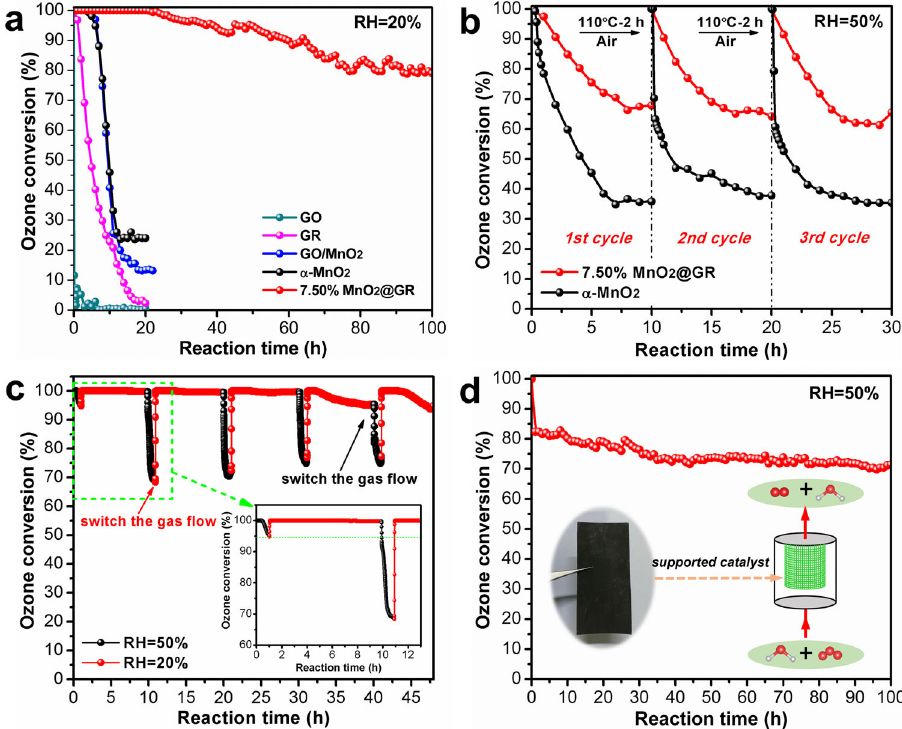
Fig. 4 The highly ef fi cient ozone conversion with the 3D hierarchical MnO 2 @GR. a Ozone conversion on GO, GR, α -MnO 2 , GO/MnO 2 and 7.50% MnO 2 @GR, respectively. b Ozone conversion on α -MnO 2 and 7.50% MnO 2 @GR at 50%RH and their regeneration performance (Regeneration condition: 110 °C, air atmosphere). c Ozone conversion on 7.50% MnO 2 @GR at alternate relative humidity (20% RH and 50% RH). d Ozone conversion of the supported catalyst at 50% RH. Inset: Photos of 7.50% MnO 2 @GR coated on stainless steel mesh. Experimental conditions: 0.1 g of catalyst (0.25 g for d ), 50 ppm O 3 , fl ow rate = 900 mL min − 1 , 25